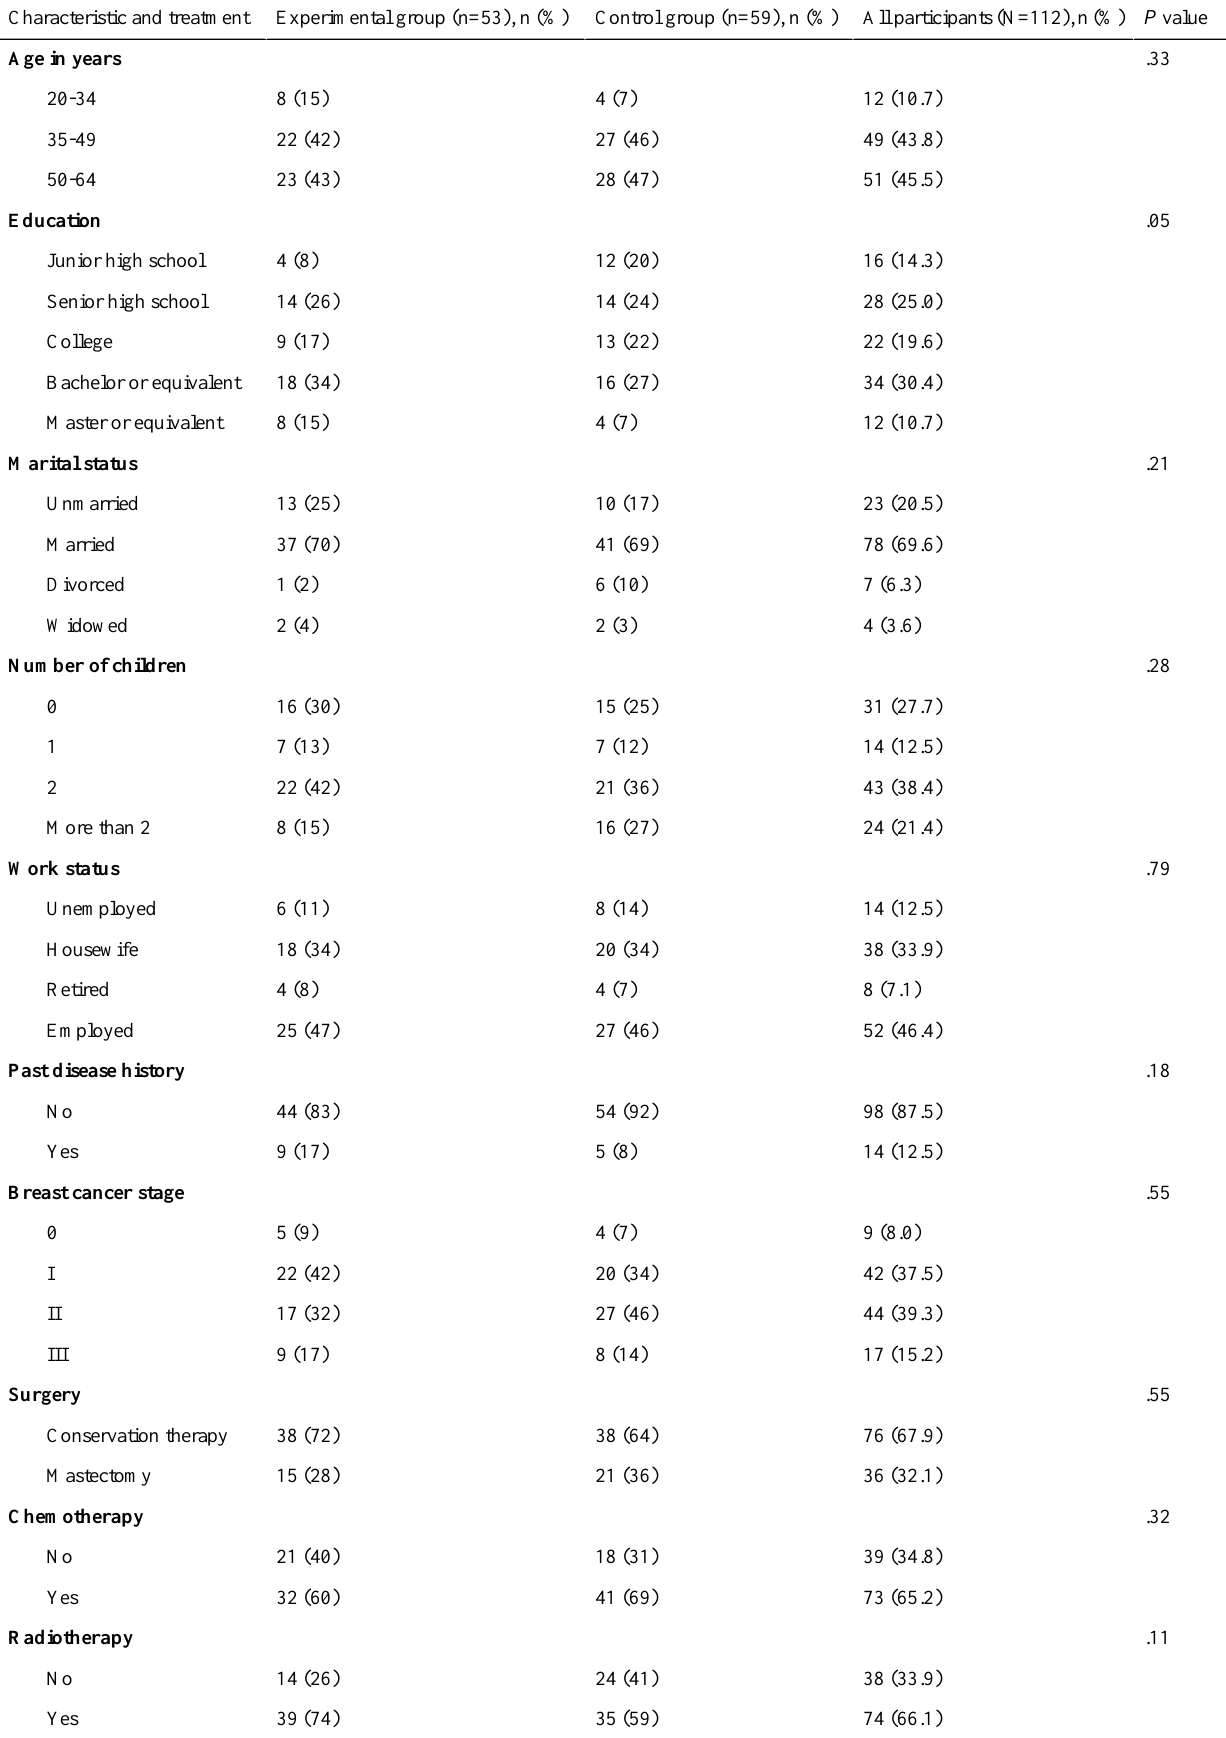
Table 2. Demographic characteristics and treatments of the